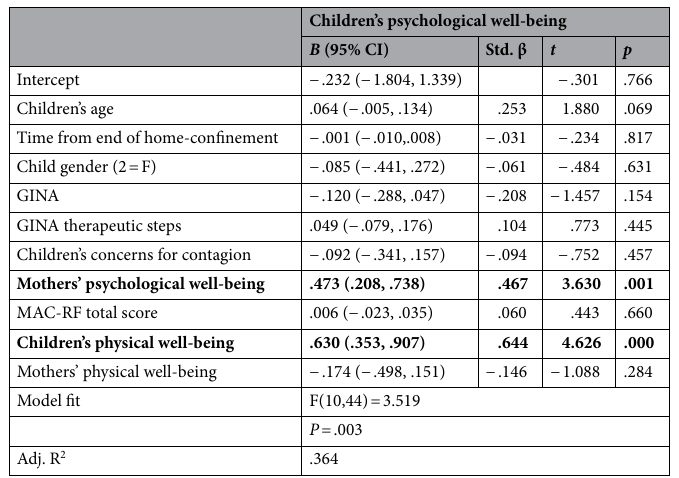
Table 4. Multiple linear regression model of asthmatic children’s psychological well-being (n = 45). Bold for p -values < .05. B , unstandardized beta; std. β , standardized beta; CI , confidence